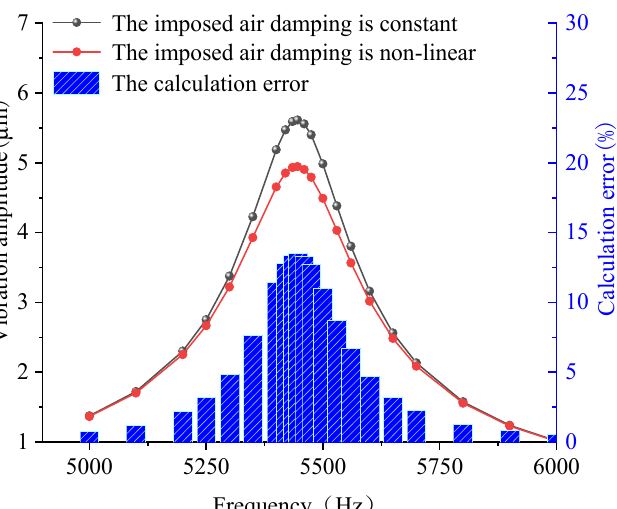
Figure 15. The frequency sweep simulation curves of the Type 3 resonator with or without damping nonlinear processing and the error percentages.